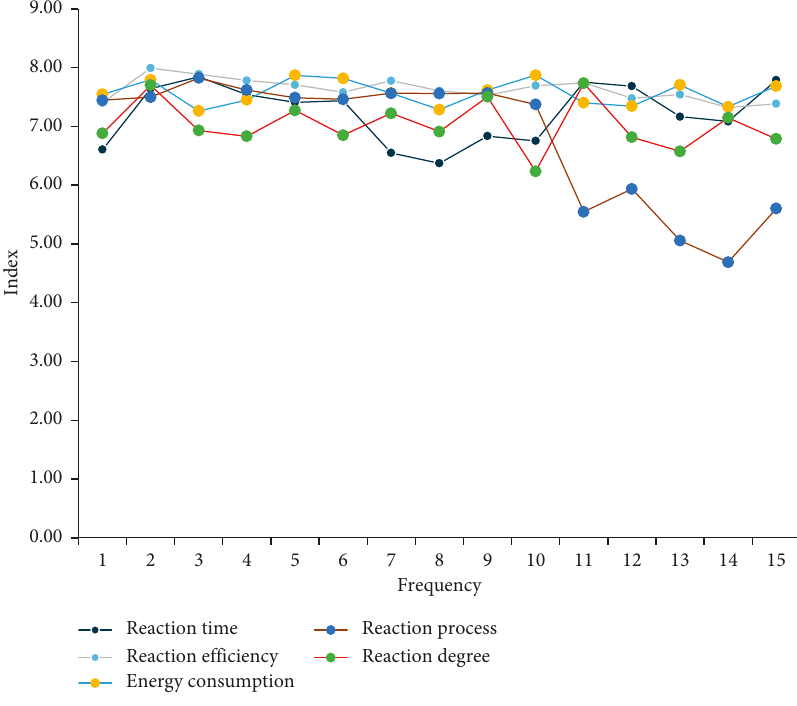
Figure 2: Fly ash test